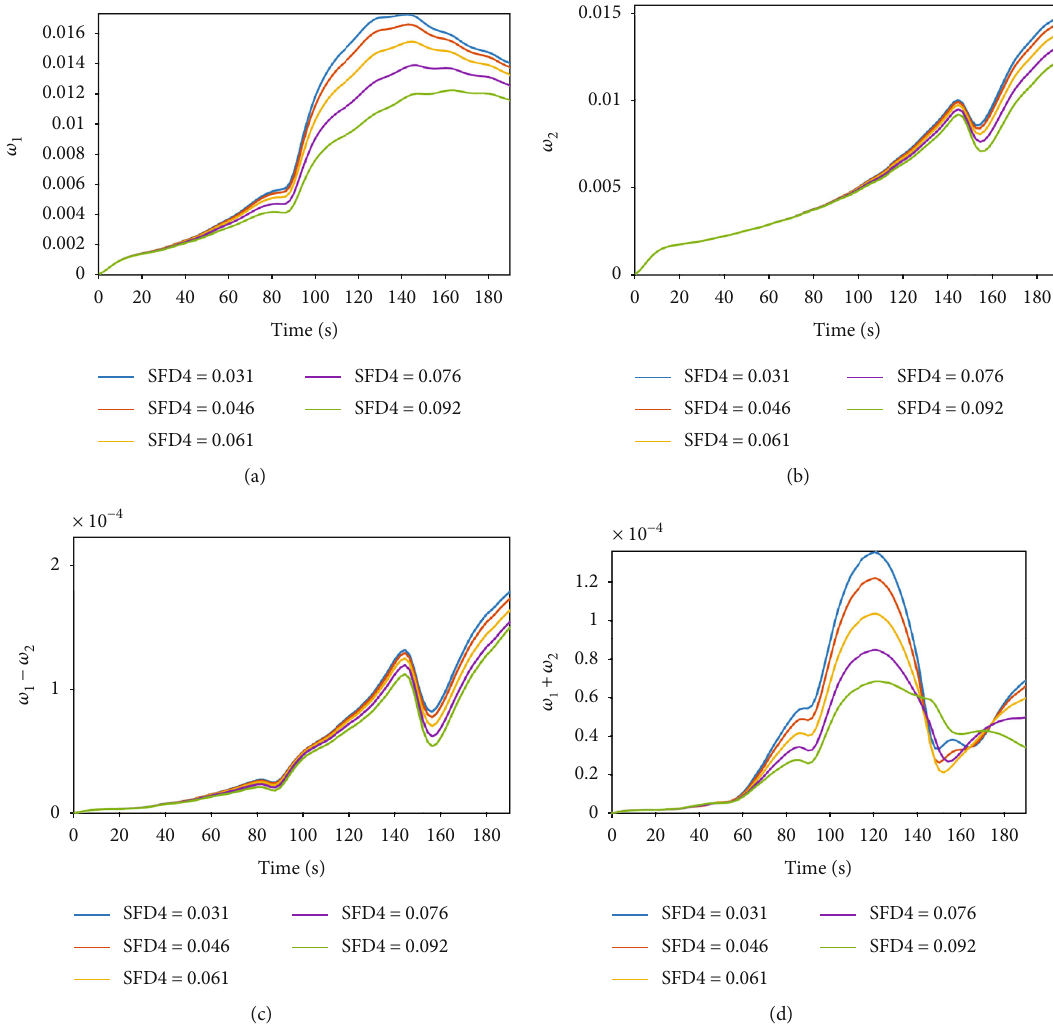
ω ω − ω ω + ω 1 ; (b) 2 ; (c) 1 2 ; (d) 1 2